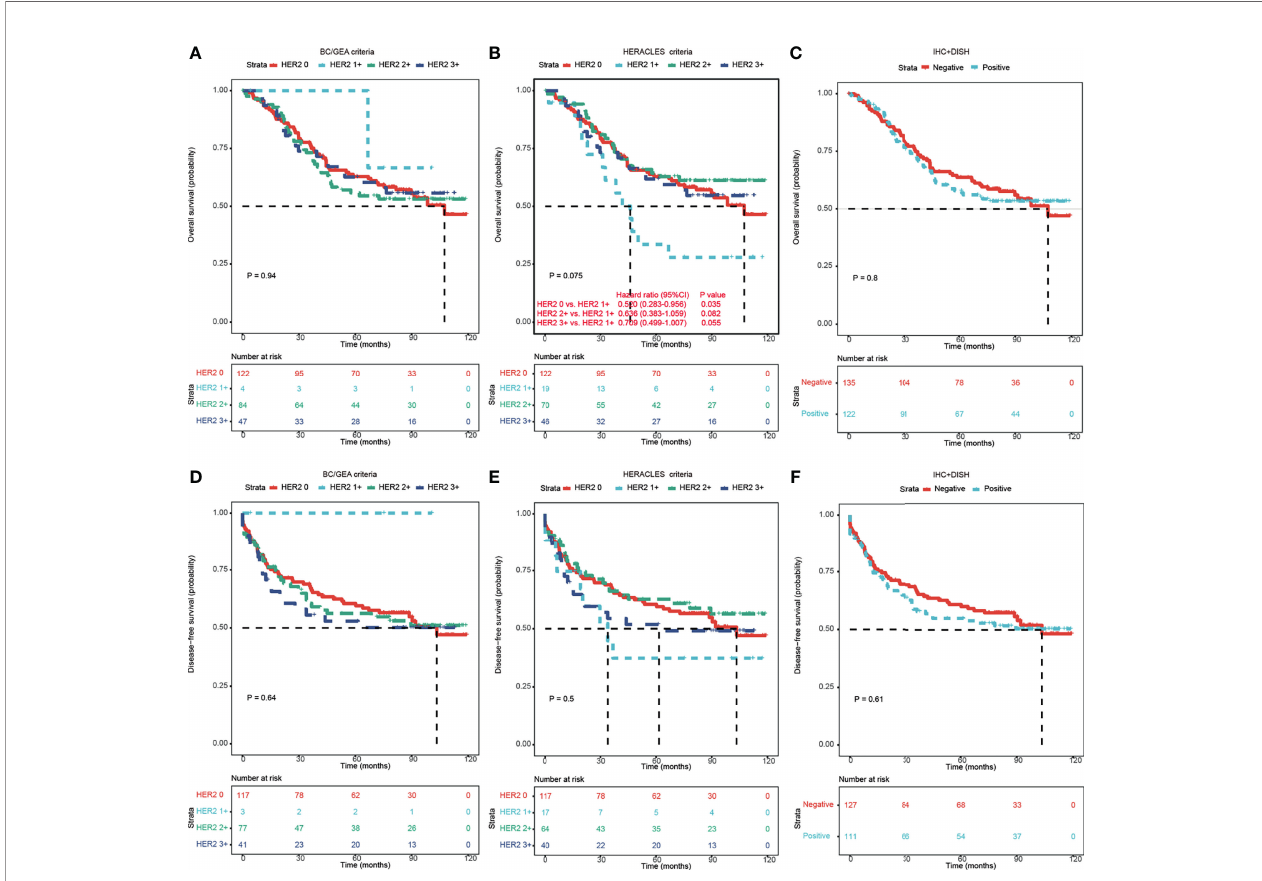
FIGURE 2 | Kaplan – Meier survival analyses of HER2 expression in CRC patients according to different criteria. (A – C) Kaplan – Meier OS analysis of HER2 expression in CRC patients according to BC/GEA criteria (A) , HERACLES criteria (B) , and HER2 expression status (C) . (D – F) Kaplan – Meier DFS analysis of HER2 expression in CRC patients according to BC/GEA criteria (D) , HERACLES criteria (E) , and HER2 expression status (F) . HER2, human epidermal growth factor receptor 2; CRC, colorectal cancer; OS, overall survival; BC, breast cancer; GEA, gastroesophageal adenocarcinoma; DFS, disease-free